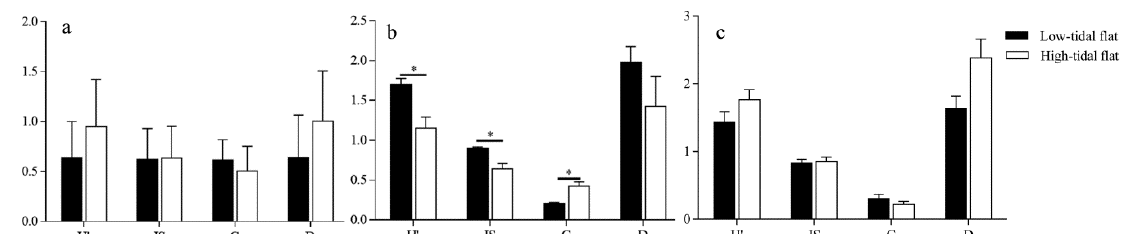
Figure 3. Comparison of the diversity indices of the different types of tidal flats in ( a ) spring, ( b ) summer, and ( c ) autumn. H’ = Shannon–Wiener index, JS = Pielou’s evenness index, C = Simpson dominance index, and D = Margalef abundance index. The values are the means ± SE. * indicates the level of significance. * = significant ( p < 0.05).